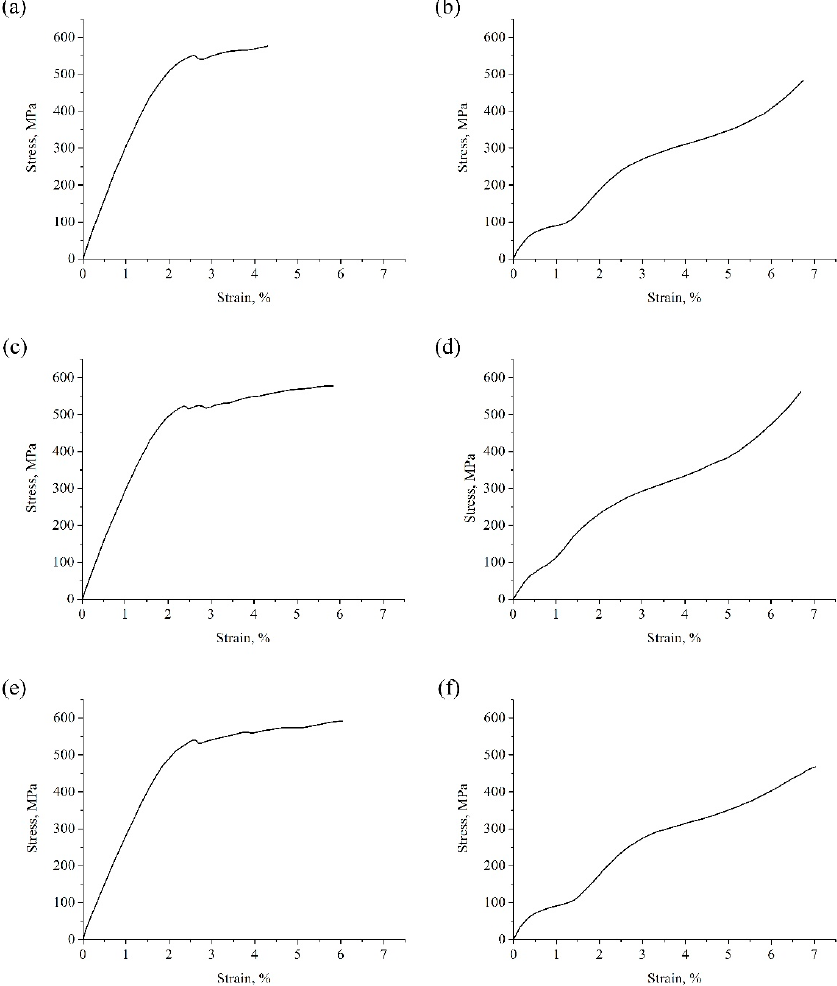
Figure 11. Tensile stress–strain curves of the NiTi WAAM samples: ( a , c , e ) as-deposited samples and ( b , d , f ) heat-treated samples grouped for three zones: ( a , b ) upper zone, ( c , d ) middle zone, and ( e , f ) lower zone.